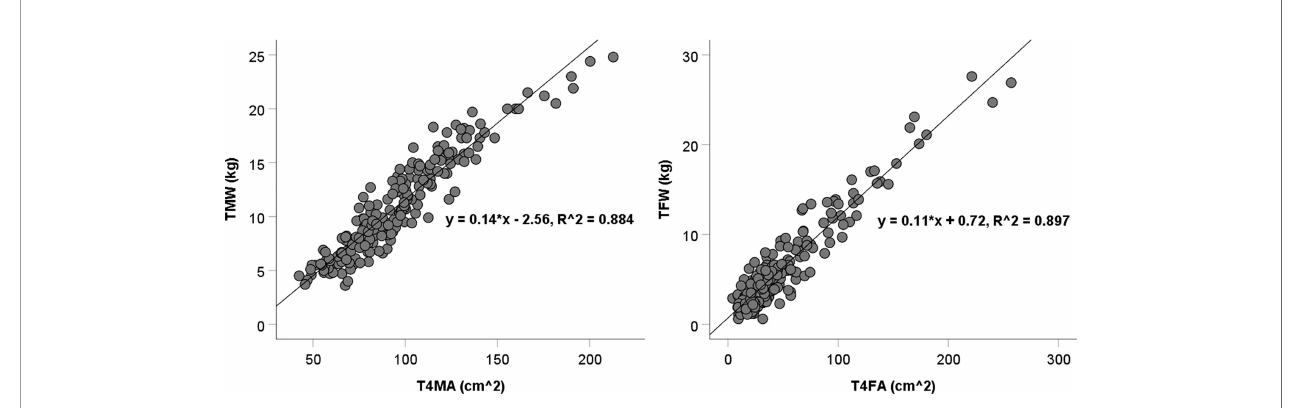
FIGURE 1 | Scatter diagram of T4MA and T4FA with TMW and TFW. TMW, total muscle weight; TFW, total fat weight; T4MA, T4 muscle area; T4FA, T4 fat area.